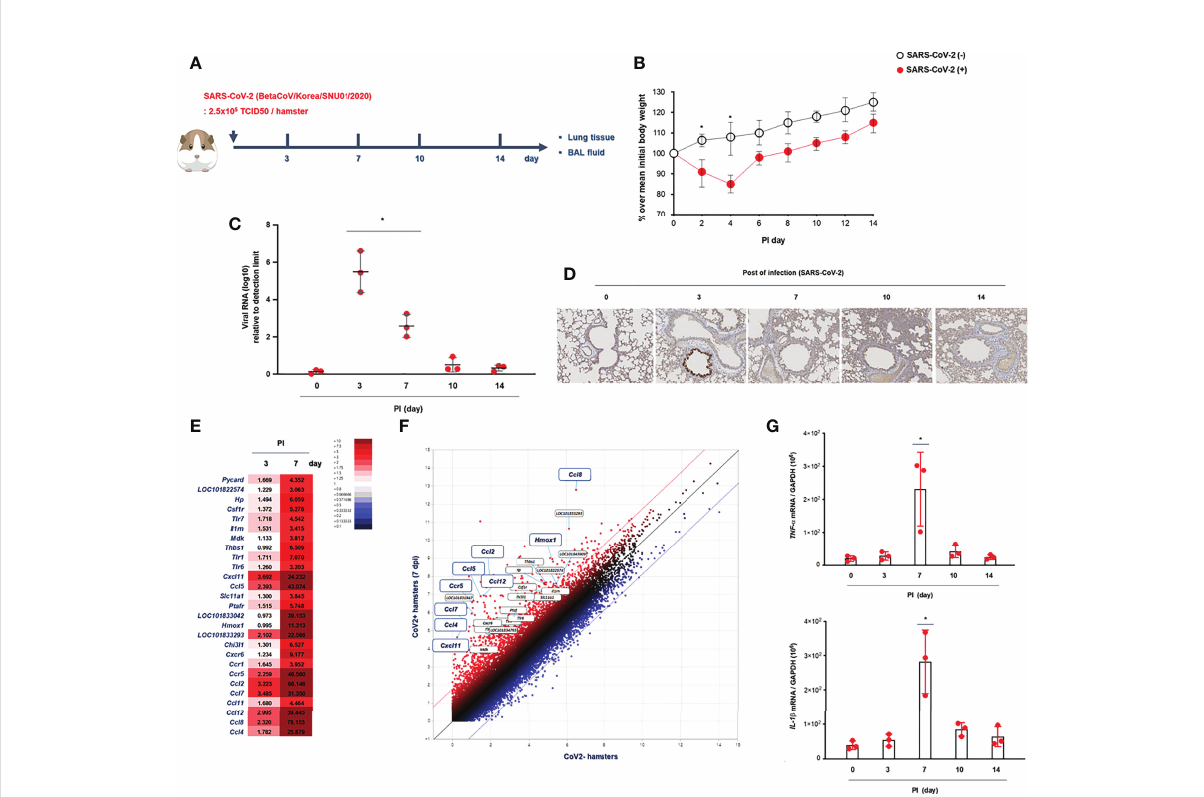
FIGURE 1 Kinetics of SARS-CoV-2 infection in vivo . (A) Schematic of the hamster model and experimental design for SARS-CoV-2 infection. Syrian golden hamsters were used in these experiments. The hamsters were infected with SARS-CoV-2 (BetaCoV/Korea/SNU01/2020, 2.5 × 10 5 TCID50/hamster) at the indicated time points (N = 3 at each indicated time point). (B) The changes in the mean body weight of SARS-CoV-2-infected mice were compared with those of non-infected hamsters (analyzed by repeated-measures two-way ANOVA). (C) Spike mRNA levels in the lung tissue were determined at 0, 3, 7, 10, and 14 dpi. (D) Immunohistochemical analysis of spike protein using DAB chromogen was performed in lung sections from hamsters prior to and following SARS-CoV-2 infection (original magni fi cation ×200). (E, F) Differentially expressed genes (DEGs) through bulk- seq using cell lysates from the lungs of SARS-CoV-2-infected hamsters were analyzed to further characterize the transcriptional alteration in response to SARS-CoV-2. The scatter plots indicating DEGs correlated with “ in fl ammatory responses. ” (G) mRNA levels of IL-1 b and TNF- a